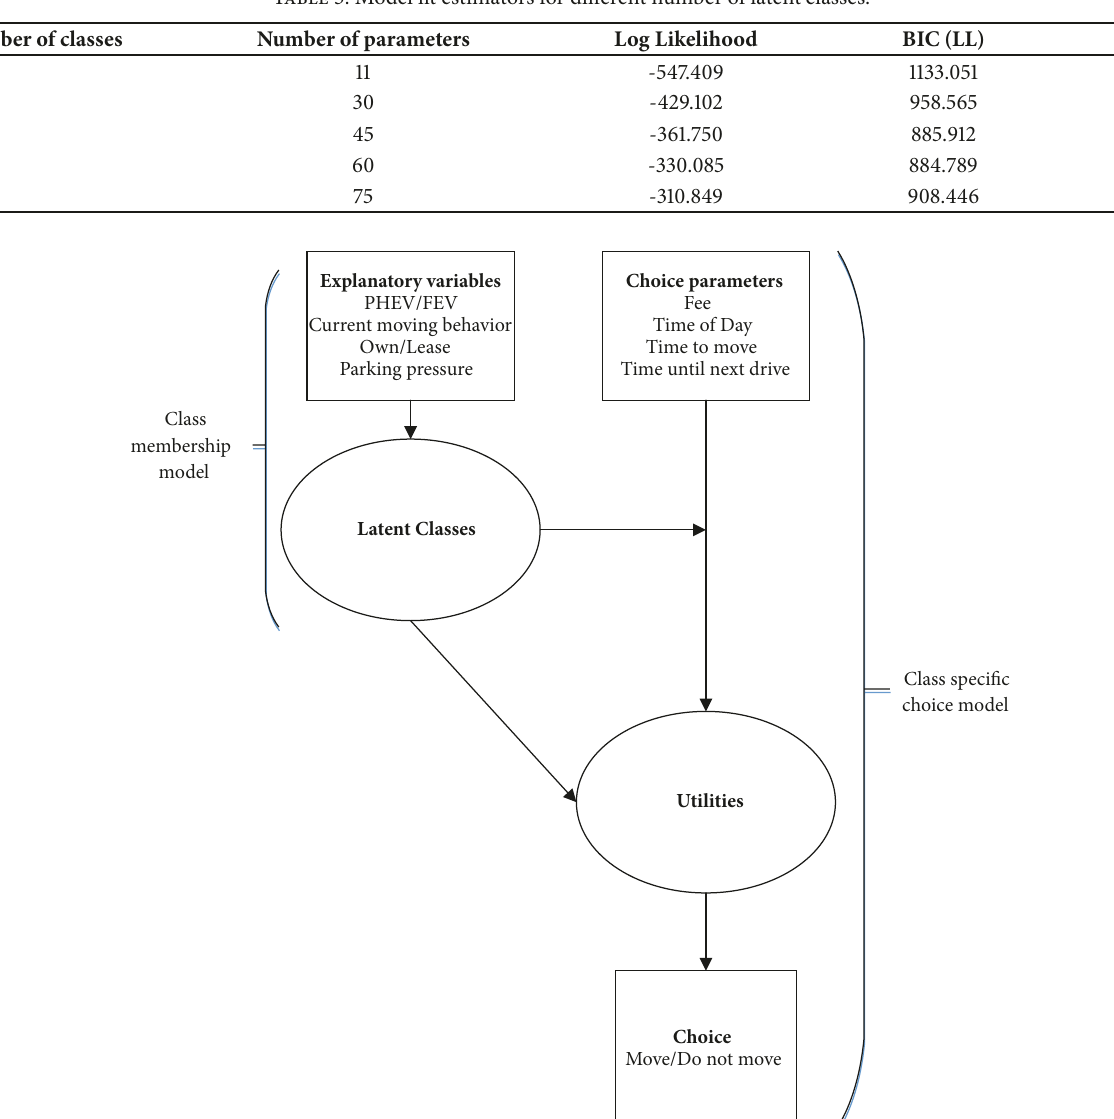
Figure 1: Visual representation of the latent class choice model, reproduced from